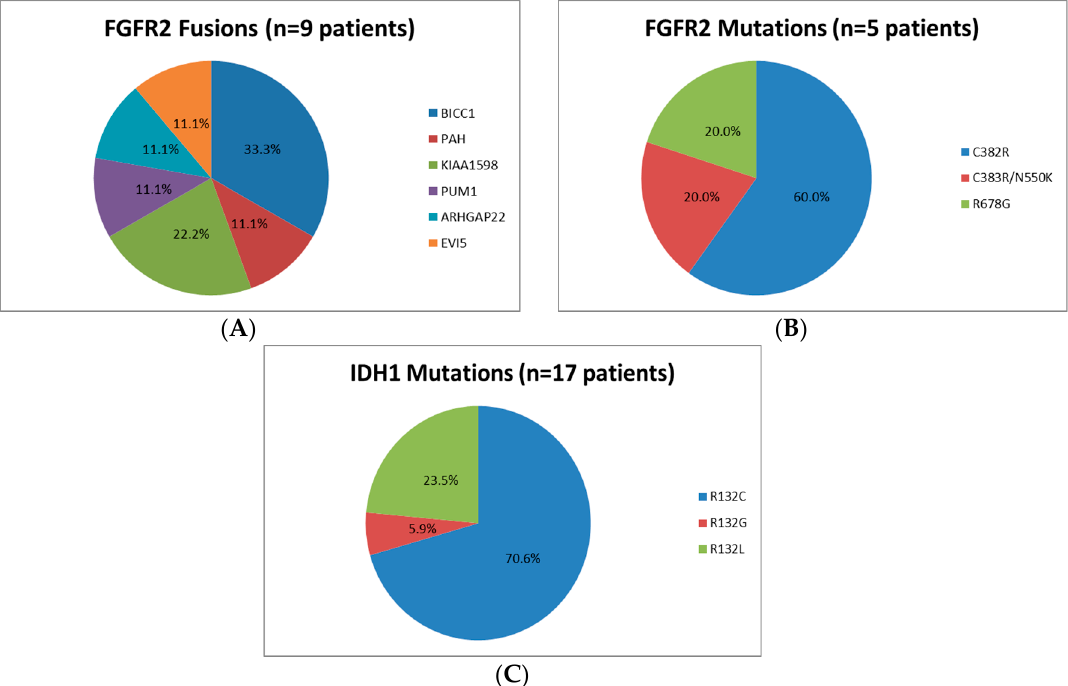
Figure 2. Description of FGFR2 and IDH1 alterations identified. Data for individual patients is provided in Table S3. ( A ): FGFR2 fusions; ( B ): FGFR2 mutations; and ( C ): IDH1 mutations.